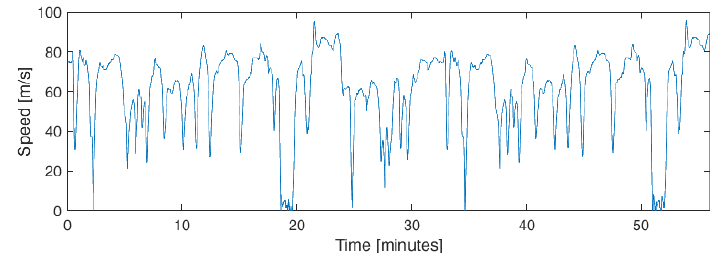
Figure 18. Speed profile, extra-urban 2.